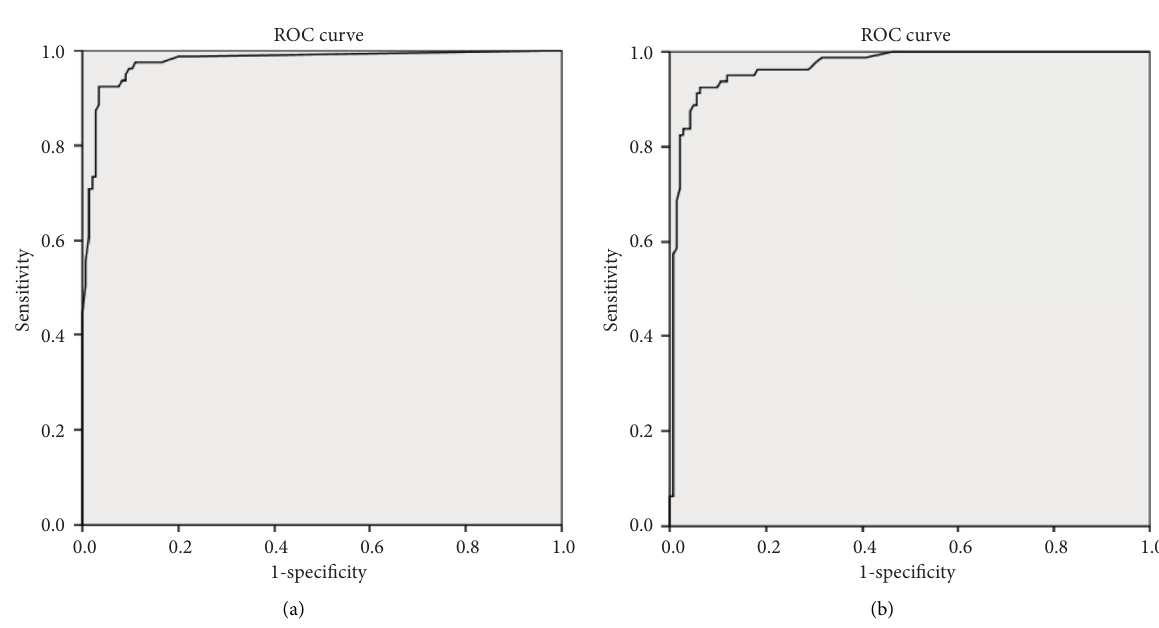
Figure 3: Receiver operating characteristic (ROC) curves for the numeric classifier: (a) the training set and (b) the test